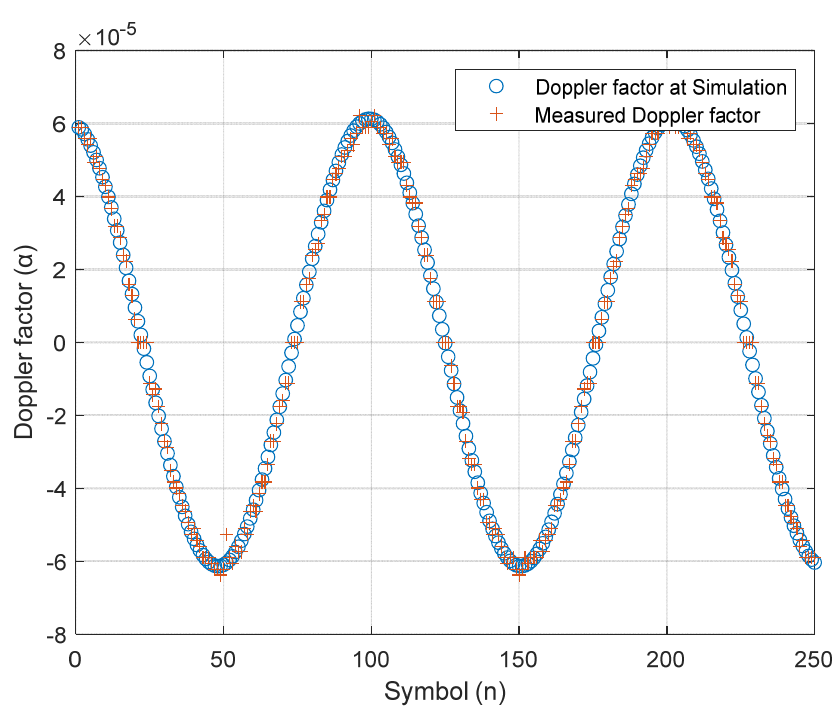
(c) Figure 11. BER performance at the same bit rate. ( a ) is when there is no artificial Doppler shift, ( b ) is with Doppler and no compensation, ( c ) is when Doppler is compensated. Figure 12 shows 𝑓 (cid:3031) measured using the Doppler bank, and Figure 13 shows the change of one symbol length according to 𝑓 (cid:3031) . It was demonstrated that the change in the